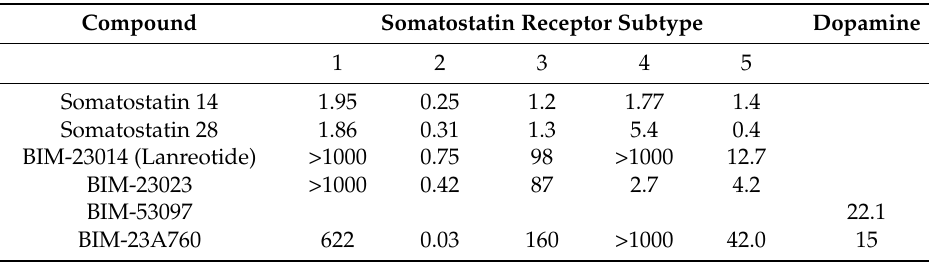
Table 2. Human Somatostatin Receptor Subtype Specificity (IC50-nM) [30,31].